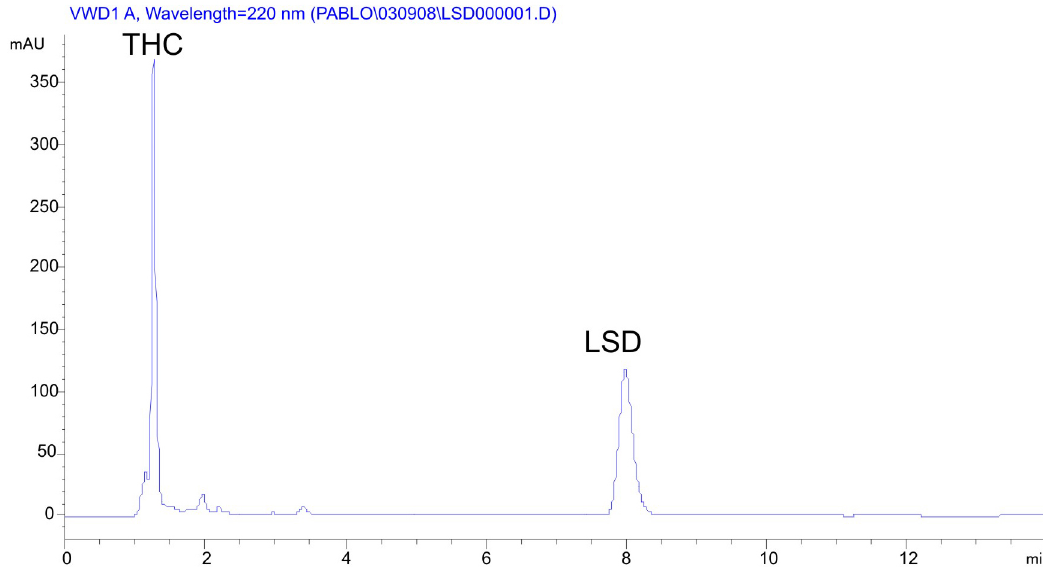
= 1.25 min) and LSD (t r